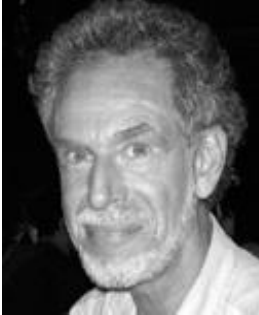
Figure A6. Clifford Voss. Figure A7. Clifford